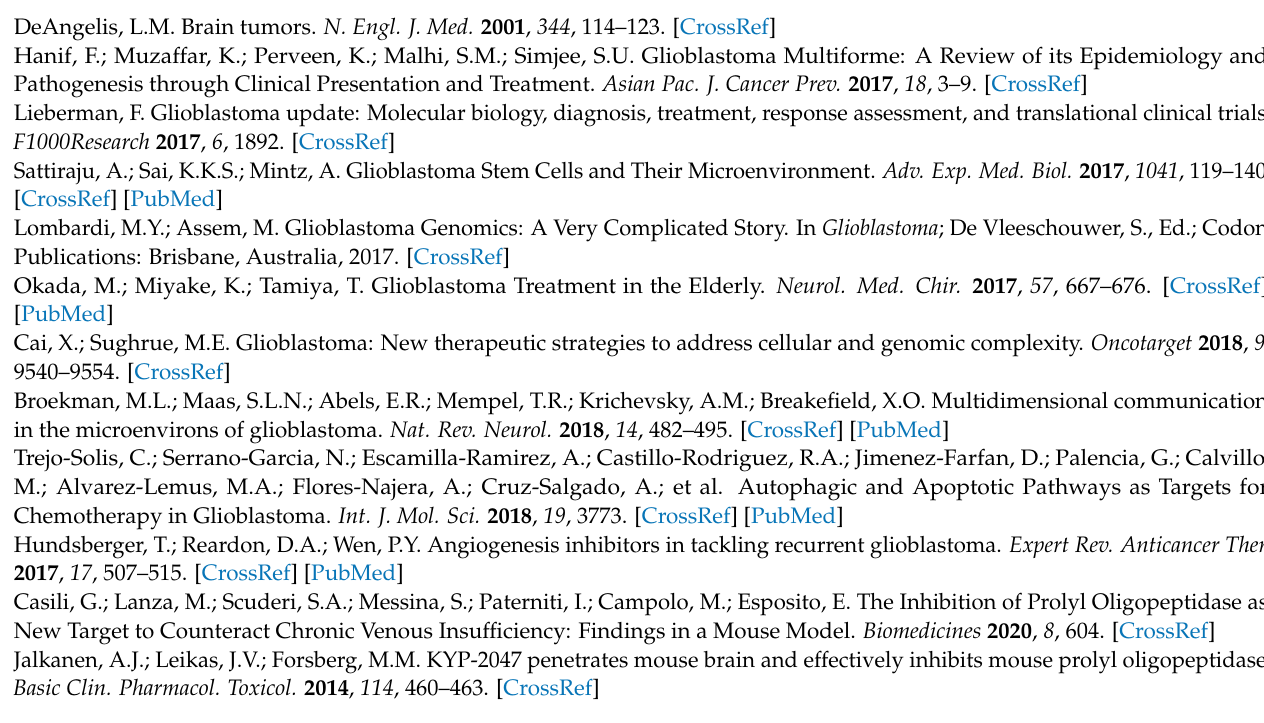
lysates., Figure S2: Effect of KYP-2047 on apoptosis pathway in U-138 cell lysates., Figure S3: Effect of KYP-2047 on TGF- β and Caspase3 expression in A-172 cells., Figure S4: Effect of KYP-2047 on TGF- β and Caspase3 expression in U-138 cells., Figure S5: Original western